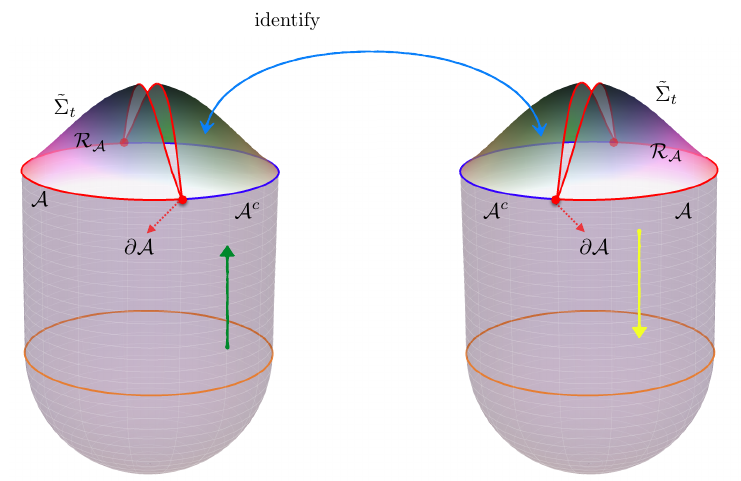
Figure 5. Bulk configurations relevant to computing the bulk dual of the boundary density matrix ( t ) . The forward evolution for | Ψ i (left) proceeds up to ˜Σ ρ A h Ψ | starts there (right). We have identified the bra and ket spacetime along R A c in accord with the prescription for the bulk dual of ρ and summing over all metrics would compute the trace of ρ